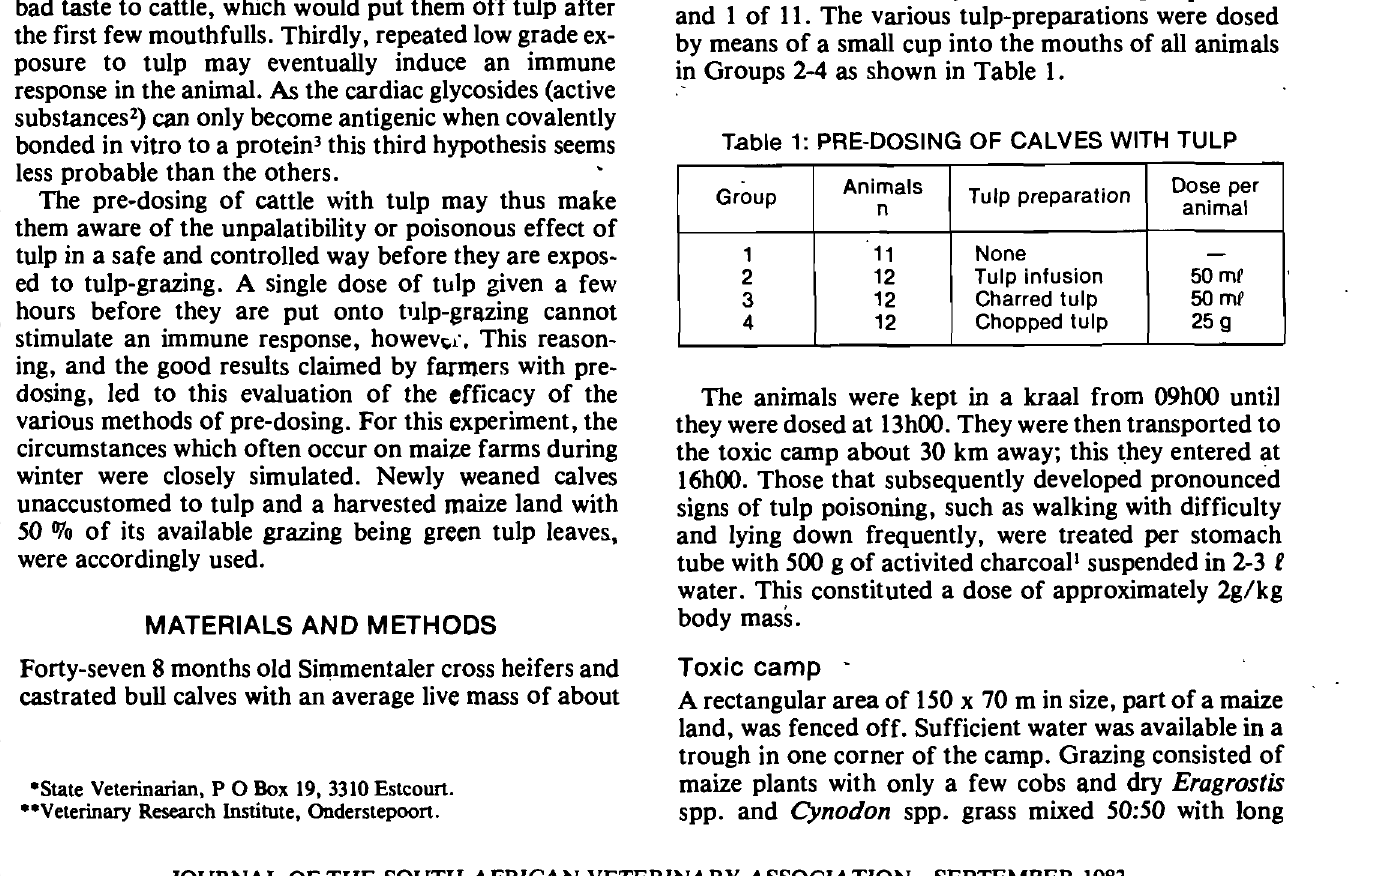
Table 1: PRE-DOSING OF CALVES WITH